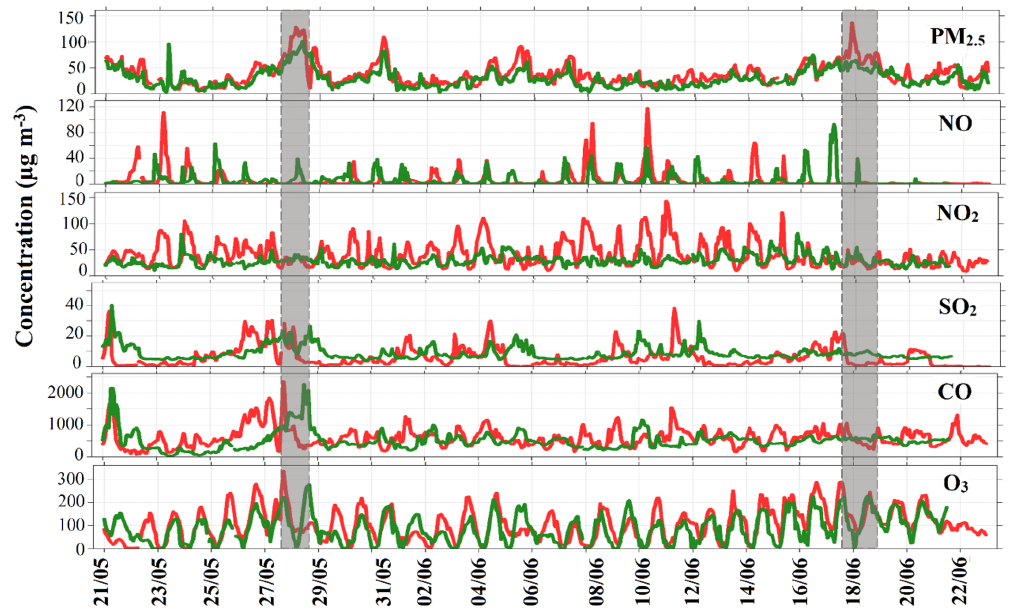
Figure 8. Time series of air quality variables at the urban and rural sites during the summer campaign. Two minor haze events are indicated